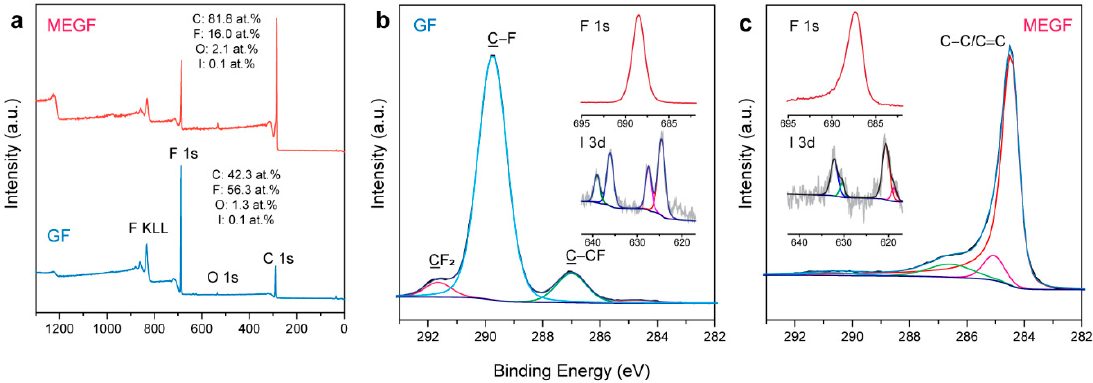
Figure 4. XPS surveys ( a ) and C 1s spectra ( b , c ) of GF and MEGF. The insets show the F 1s and I 3d spectra. The colored lines show the curve fitting components.